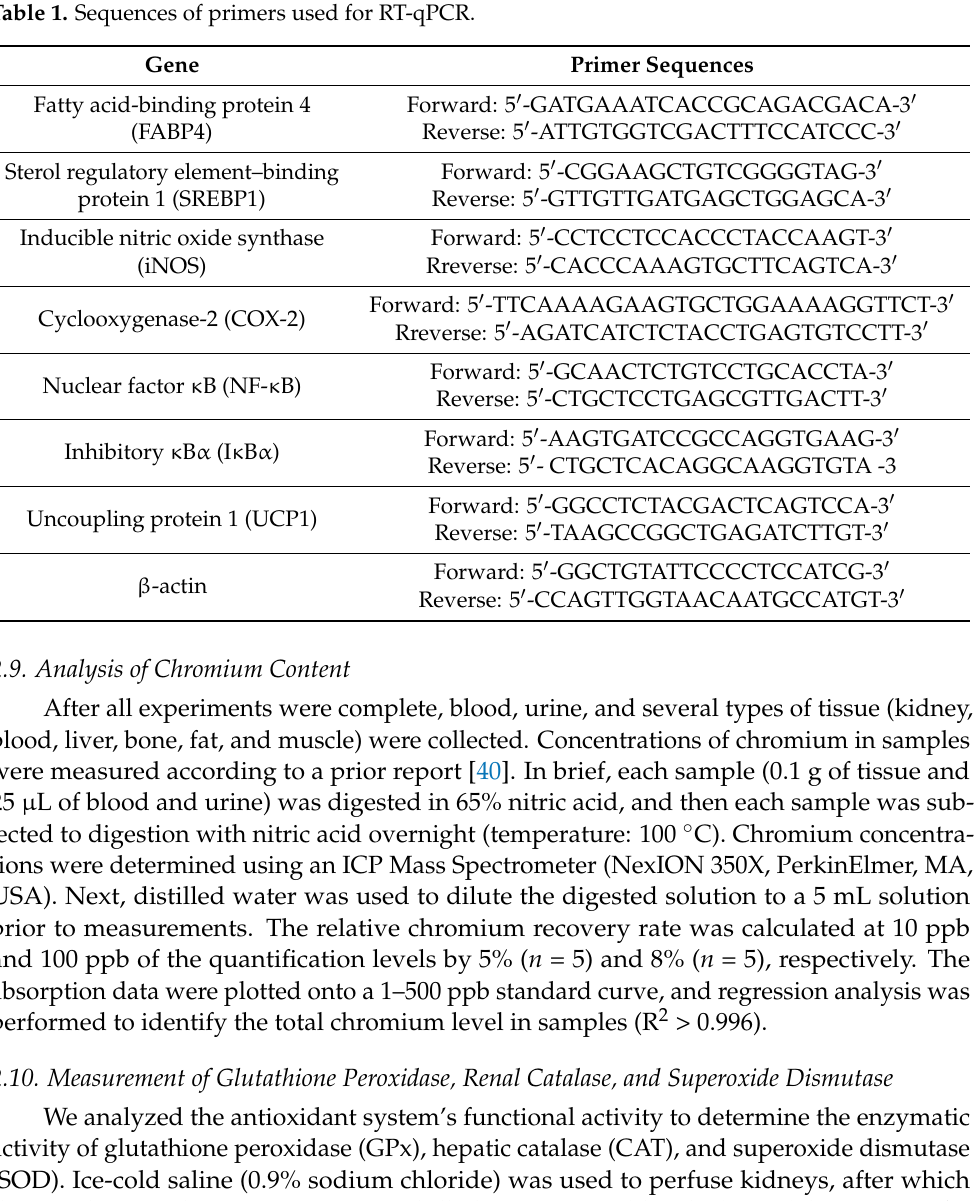
Table 1. Sequences of primers used for